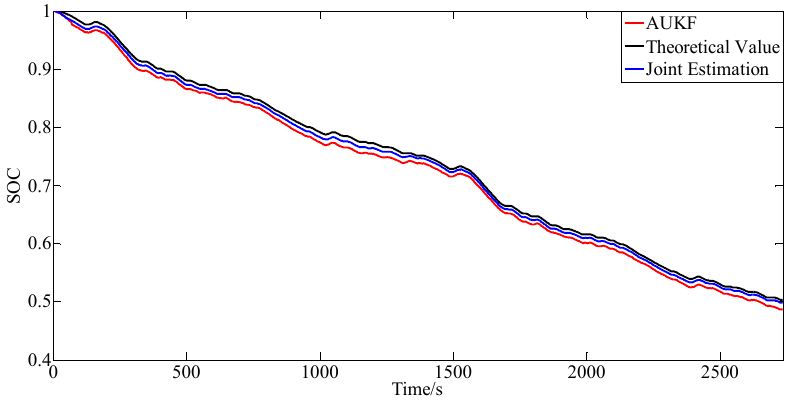
Figure 11. Comparison of the SOC estimates.